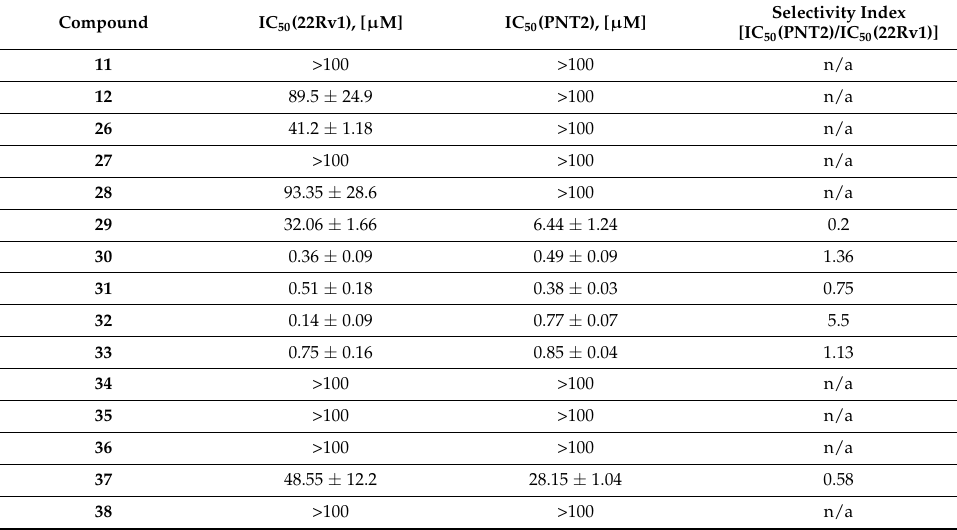
Table 1. Cytotoxicity of the synthesized compounds in cancer (22Rv1) versus non-cancer (PNT2) prostate cells. Selectivity index values (ratio of IC 50 in PNT2 cells to IC 50 in 22Rv1 cells). “#” indicates that IC 50 values toward the tested cell lines were >100 µ M. The values of IC 50 correspond to those presented in Table 2. All IC 50 values were evaluated after 48 h of treatment using the MTT test.